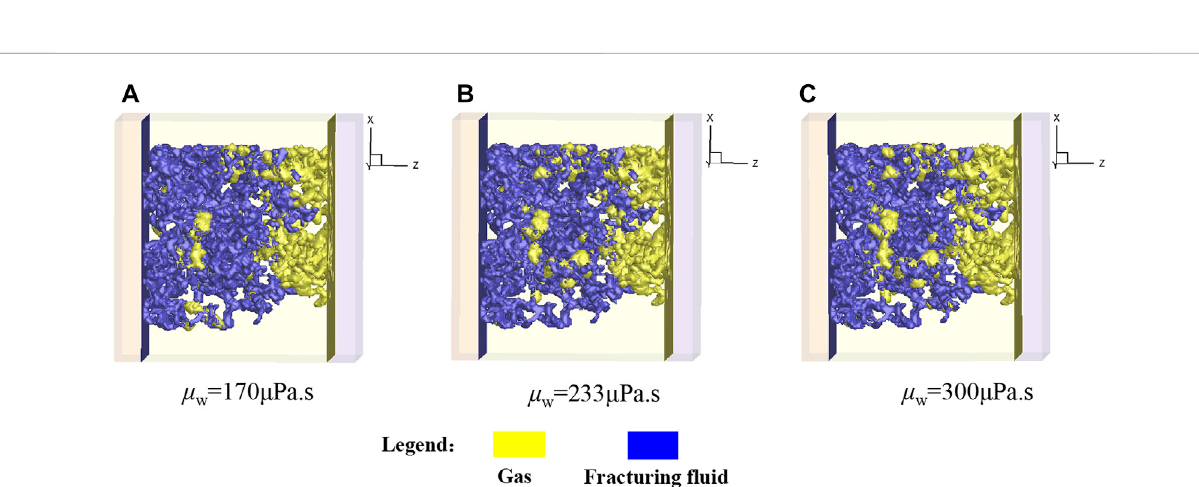
Frontiers in Earth